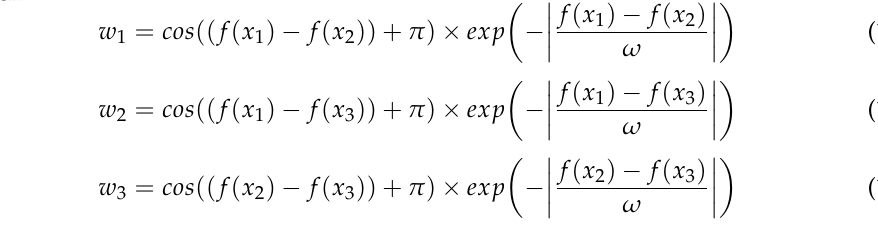
Figure 4. Weighted mean for a set of solutions/vectors.